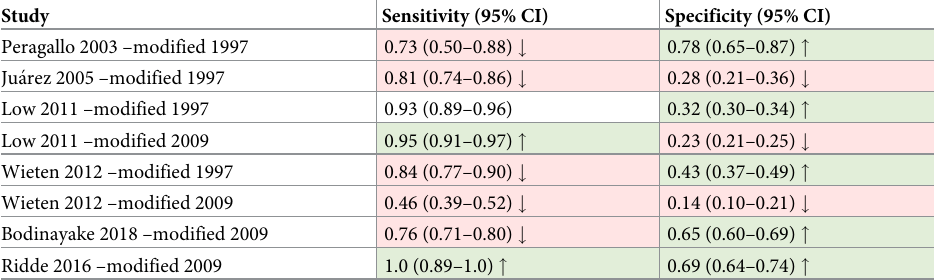
Green shading indicates better performance than the corresponding definition’s summary estimate (i.e. better than unmodified criteria). Red shading indicates the